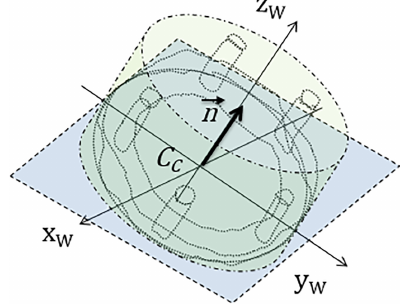
Figure 2. Extracted flange. Figure 3. Associated Chebyshev plane (element with dashed edges) and minimum-circumscribed cylinder (element with dash-dotted edges) for the flange.